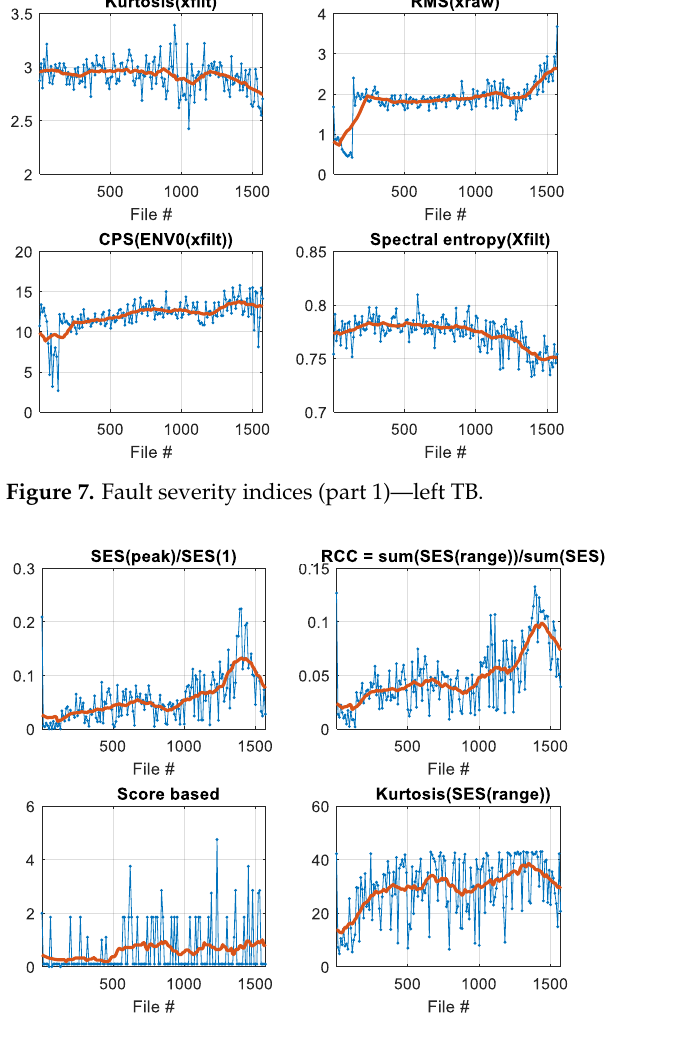
Figure 8. Fault severity indices (part 2)—left TB.